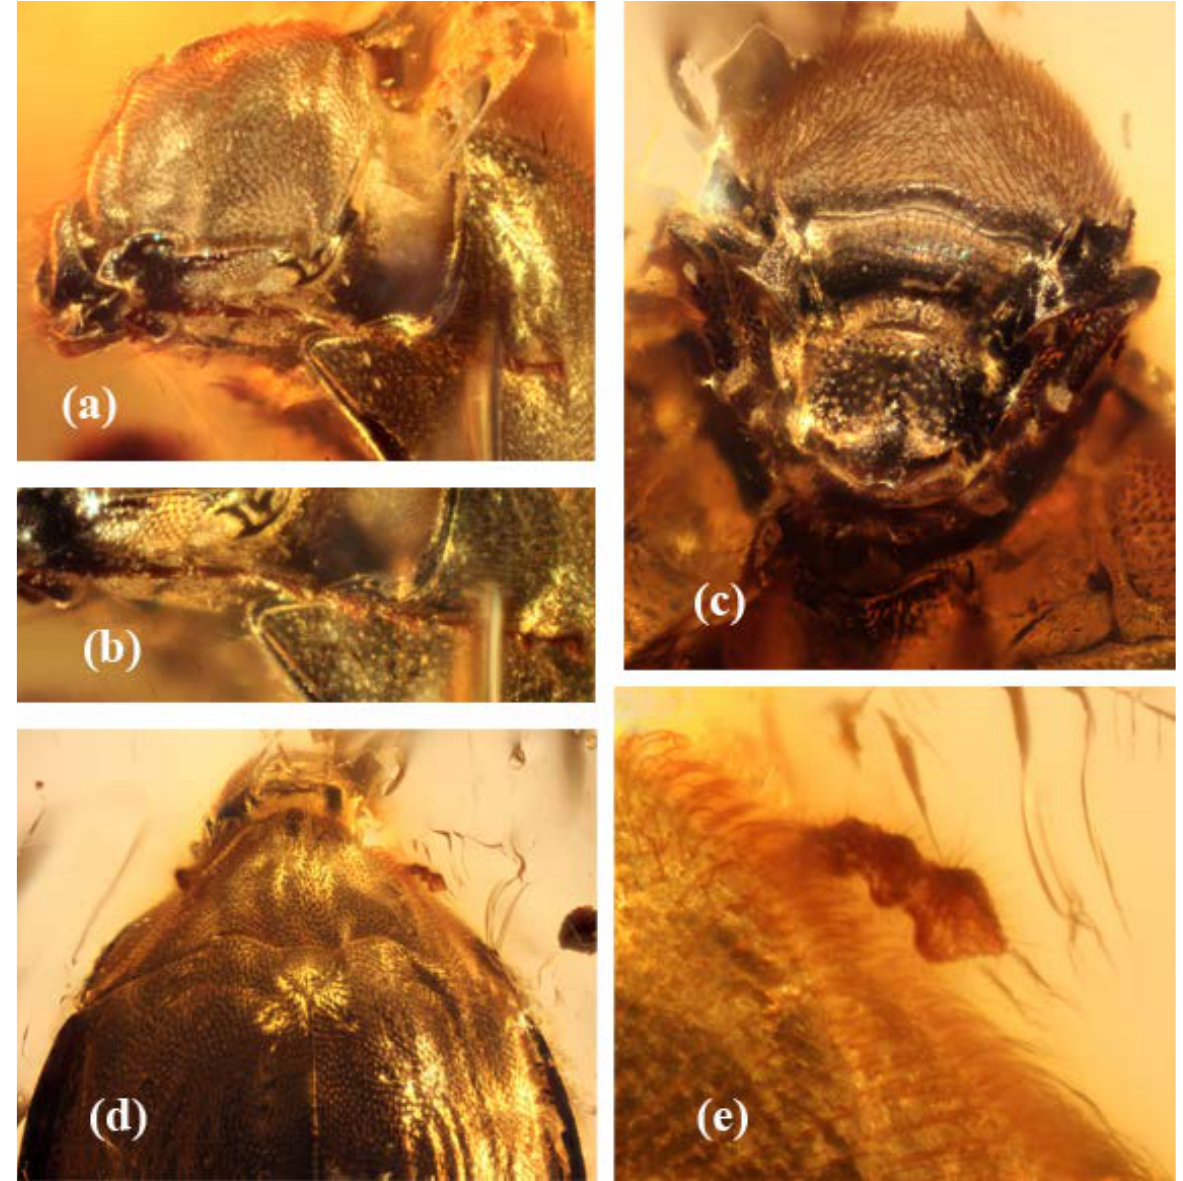
Figure 3. Burmochares groehni Kirejtshuk et Prokin, gen. et sp. nov. , holotype (GPIH no. 5071, CCGG no. 20037, LIBH): ( a ) head with right antenna, laterally; ( b ) right antenna; ( c ) head ventrally; ( d ) head, pronotum, apical segments of the left antenna, scutellum and the base of elytra, dorsally; ( e ) apical segments of the left antenna. Body length 2.85 mm.